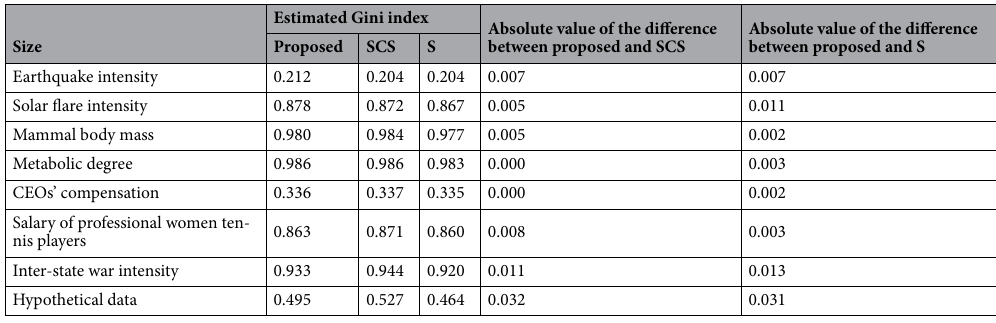
Table 6. The comparison of values of the estimated Gini index calculated based on the proposed model, the SCS model, and the S